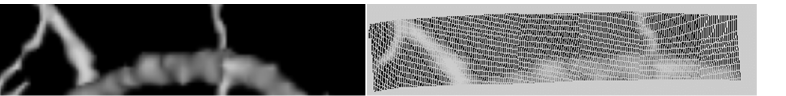
Figure 6. Project 2D scanlines onto a head phantom for calculating surface-based distortions.